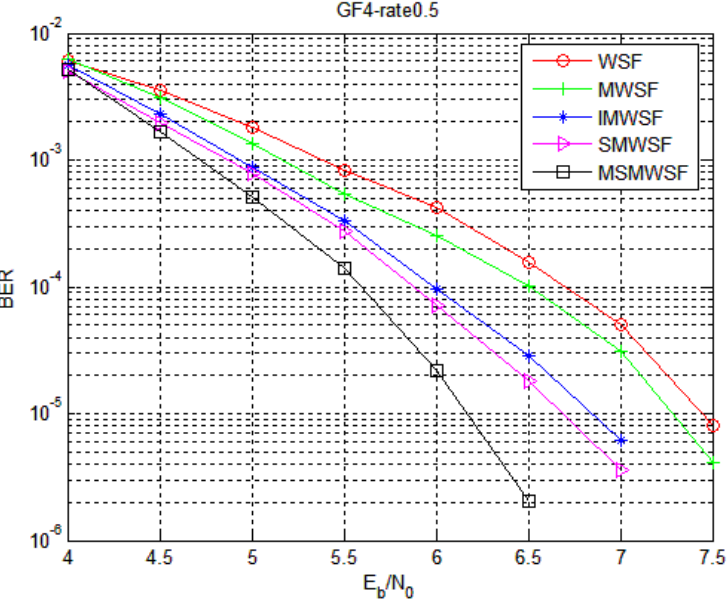
Figure 5. Comparison of five algorithms under Code 1.